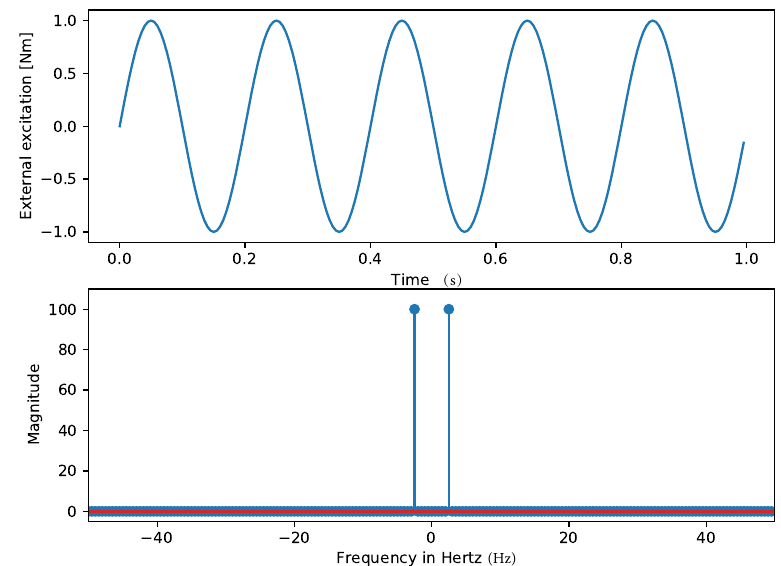
Figure 4. Fluctuating excitation and its frequency